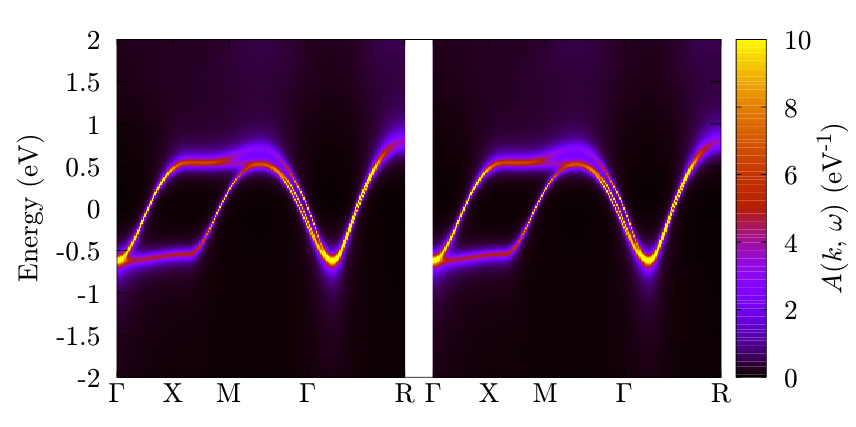
Figure 14: A ( k , ω ) for each spin component computed by DMFT for the Wannier model of SrVO 3